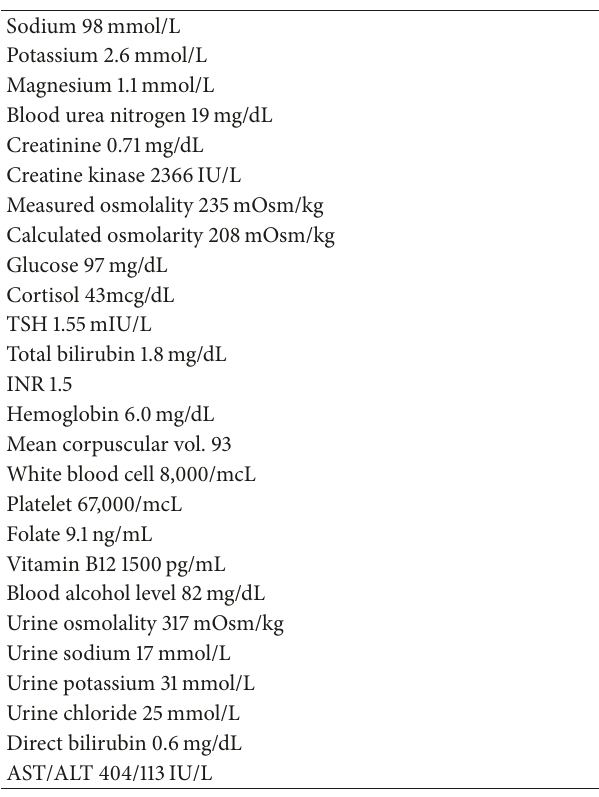
Table 1: Laboratory data at the time of admission.